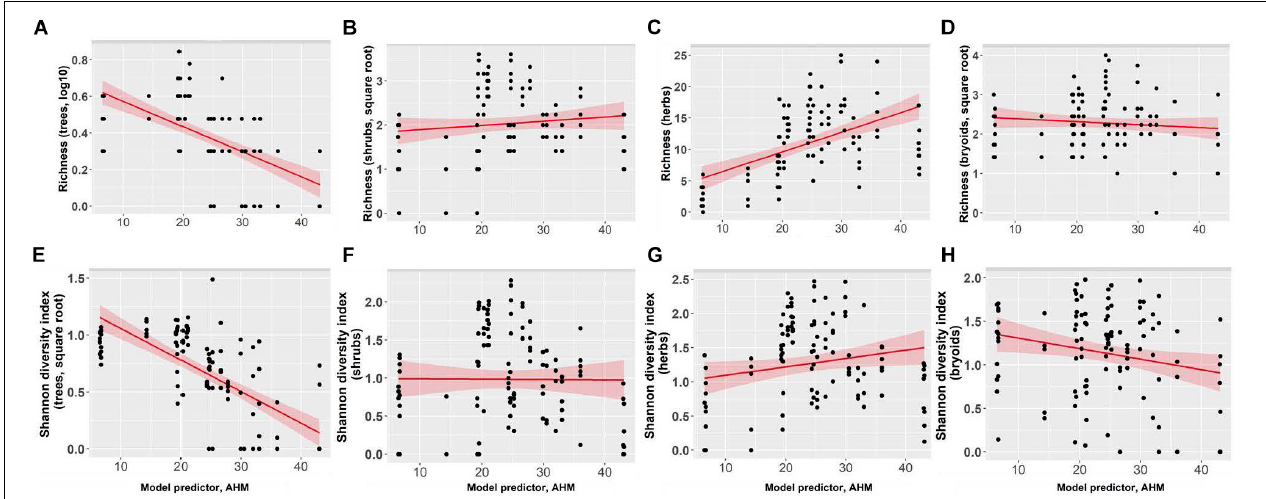
FIGURE 6 | Effect of annual heat moisture index (AHM) on richness for panels (A) trees, (B) shrubs, (C) herbs, and (D) bryoids, and Shannon’s diversity index for panels (E) trees, (F) shrubs, (G) herbs, and (H) bryoids. In each figure each point represents one measurement per plot (113 plots in total). Shannon’s diversity index (trees) and tree richness were square root and log-transformed, respectively. Figures present square root and log10-transformed data.